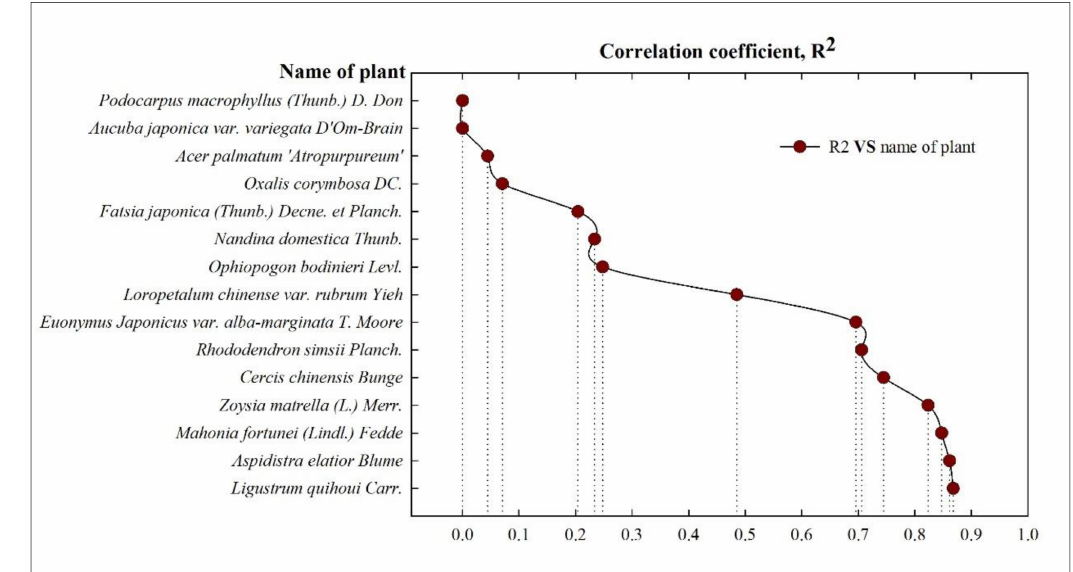
Figure 5. The ranking of the correlation coefficients (R2) for the 15 landscape plant